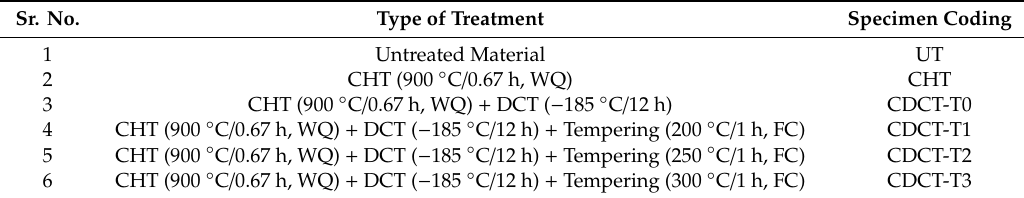
Table 4. Thermal treatment schedules and coding of specimens.